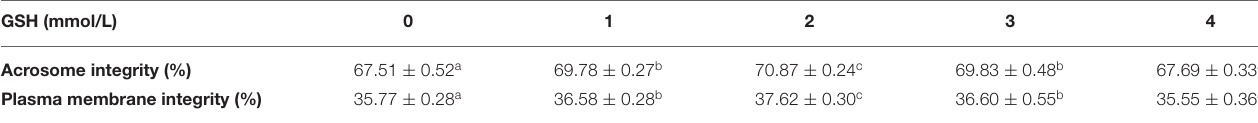
TABLE 2 | Effect of glutathione (GSH) on the sperm acrosome and plasma membrane integrity of Guanzhong dairy goats after thawing.